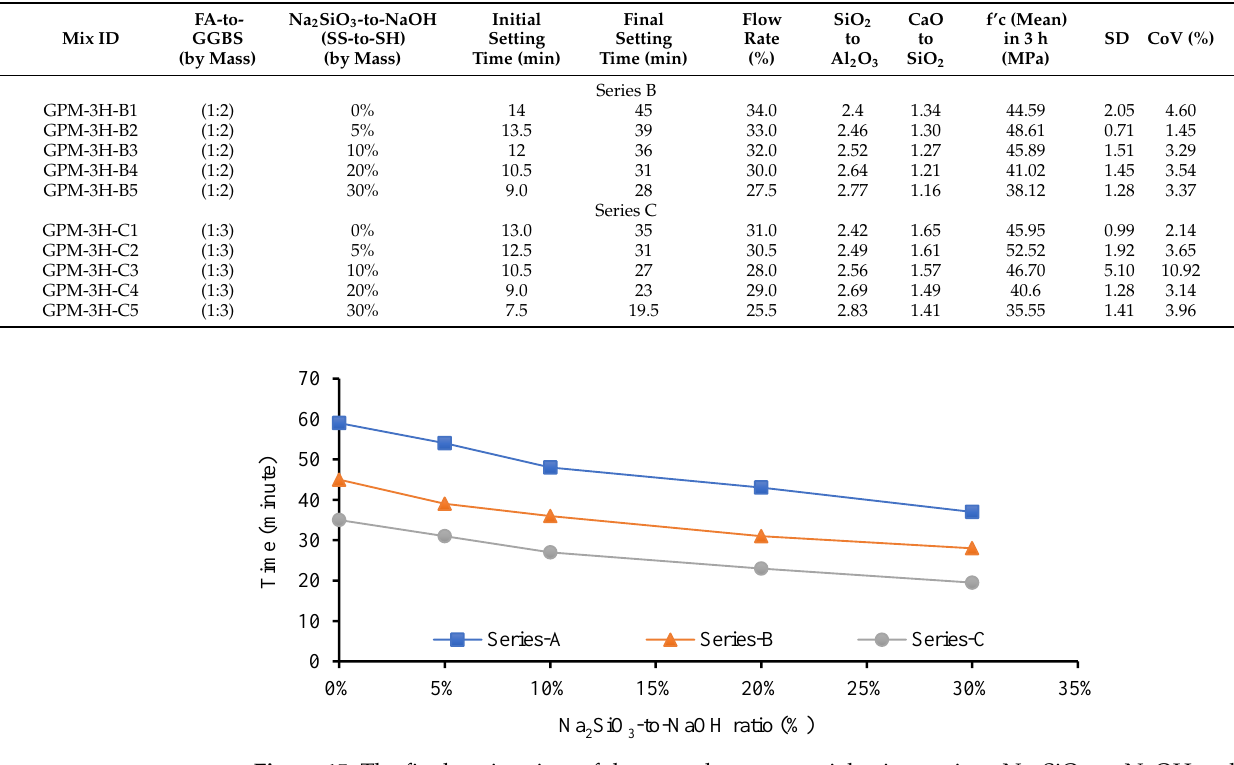
Figure 15. The final setting time of the geopolymer material using various Na 2 SiO 3 -to-NaOH and FA-to-GGBS ratios with sand preheated at 110 °C.